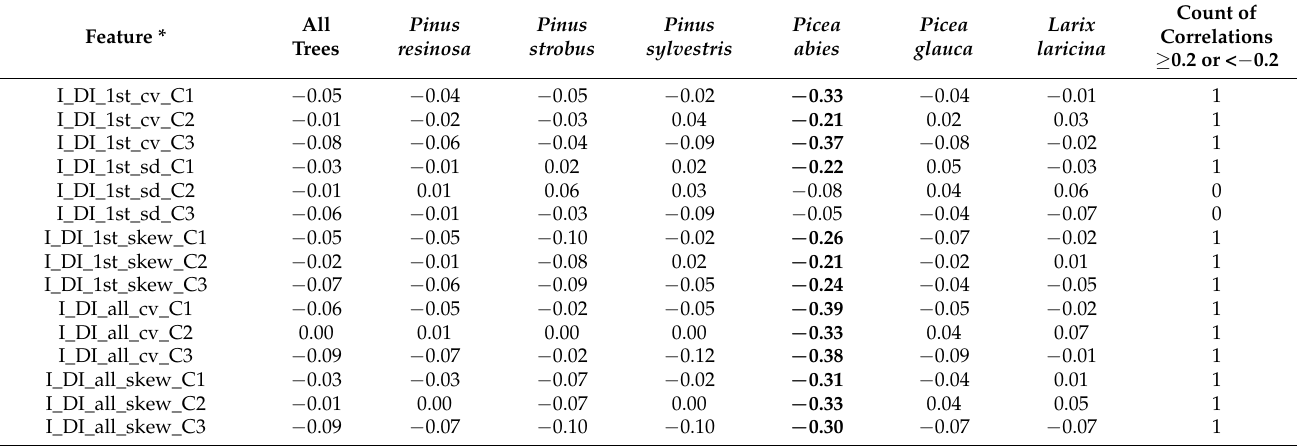
Table A3. Correlations between normalized intensity features and mean scan